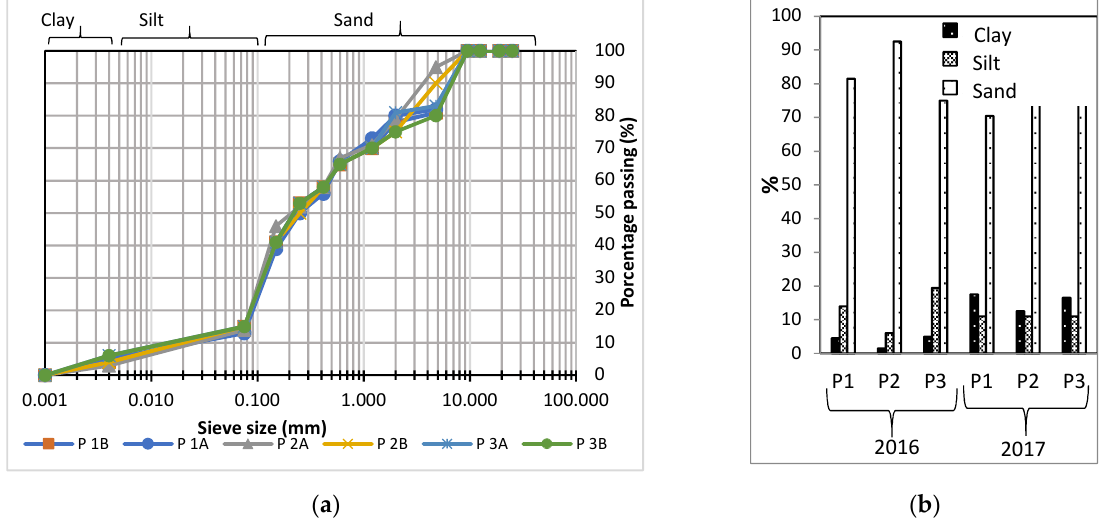
Figure 5. ( a ) Particle size distribution curves for soil swale samples in 2016. ( b ) Percentages of clay, silt and sand in samples from 2016 and 2017. Location of soil sample points; P1 is near the inlet, P2 is in the middle and P3 is near the outlet;“A” refers to 0–0.2 m depths and “B” to 0.2–0.4 m. For details, see Figure 1b.